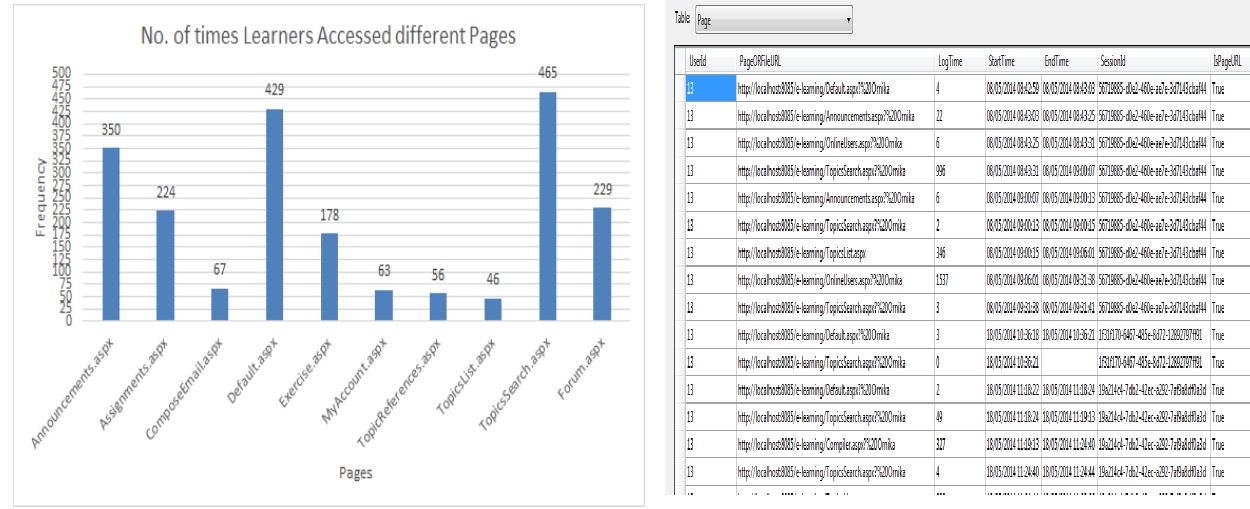
Figure 5. Analysis of Number of Times Learners Accessed Different Pages